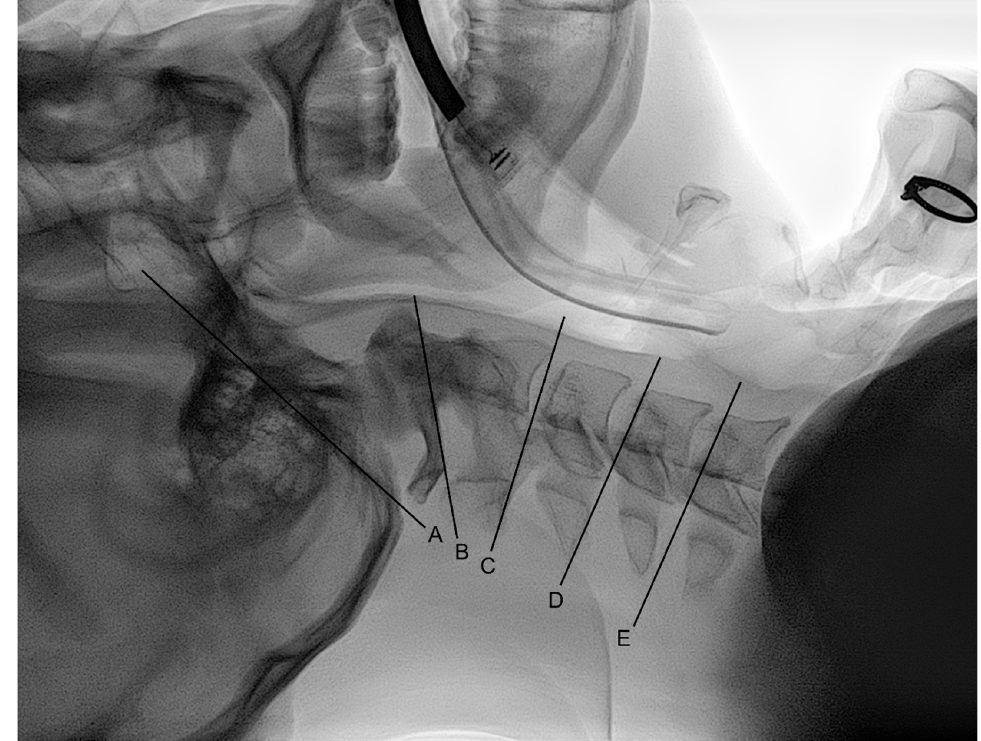
Figure 1. Reference lines of the: ( A ) occiput; ( B ) C1; ( C ) C2; ( D ) C4; ( E ) C5. The reference lines of the occiput and C1 were defined as a line connecting the sellar base and the opisthion and a line connecting the inferior cortical margin of the C1 anterior arch and the inferior cortical margin of the C1 spinous process, respectively [15,16,27]. The reference lines of C2, C4, and C5 were defined as a line connecting the antero-inferior cortical margin of the C2 body and the inferior cortical margin of the C2 spinous process and lines parallel to the endplate of the C4 and C5 body, respectively [15,16,27].